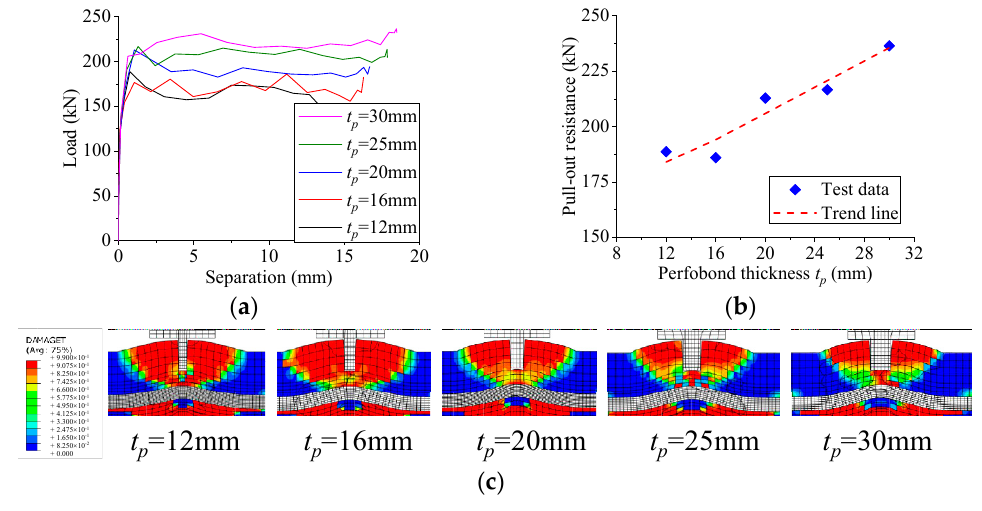
Figure 16. Influence of perfobond thickness. ( a ) Load–separation curves; ( b ) influence analysis; ( c ) failure mode.